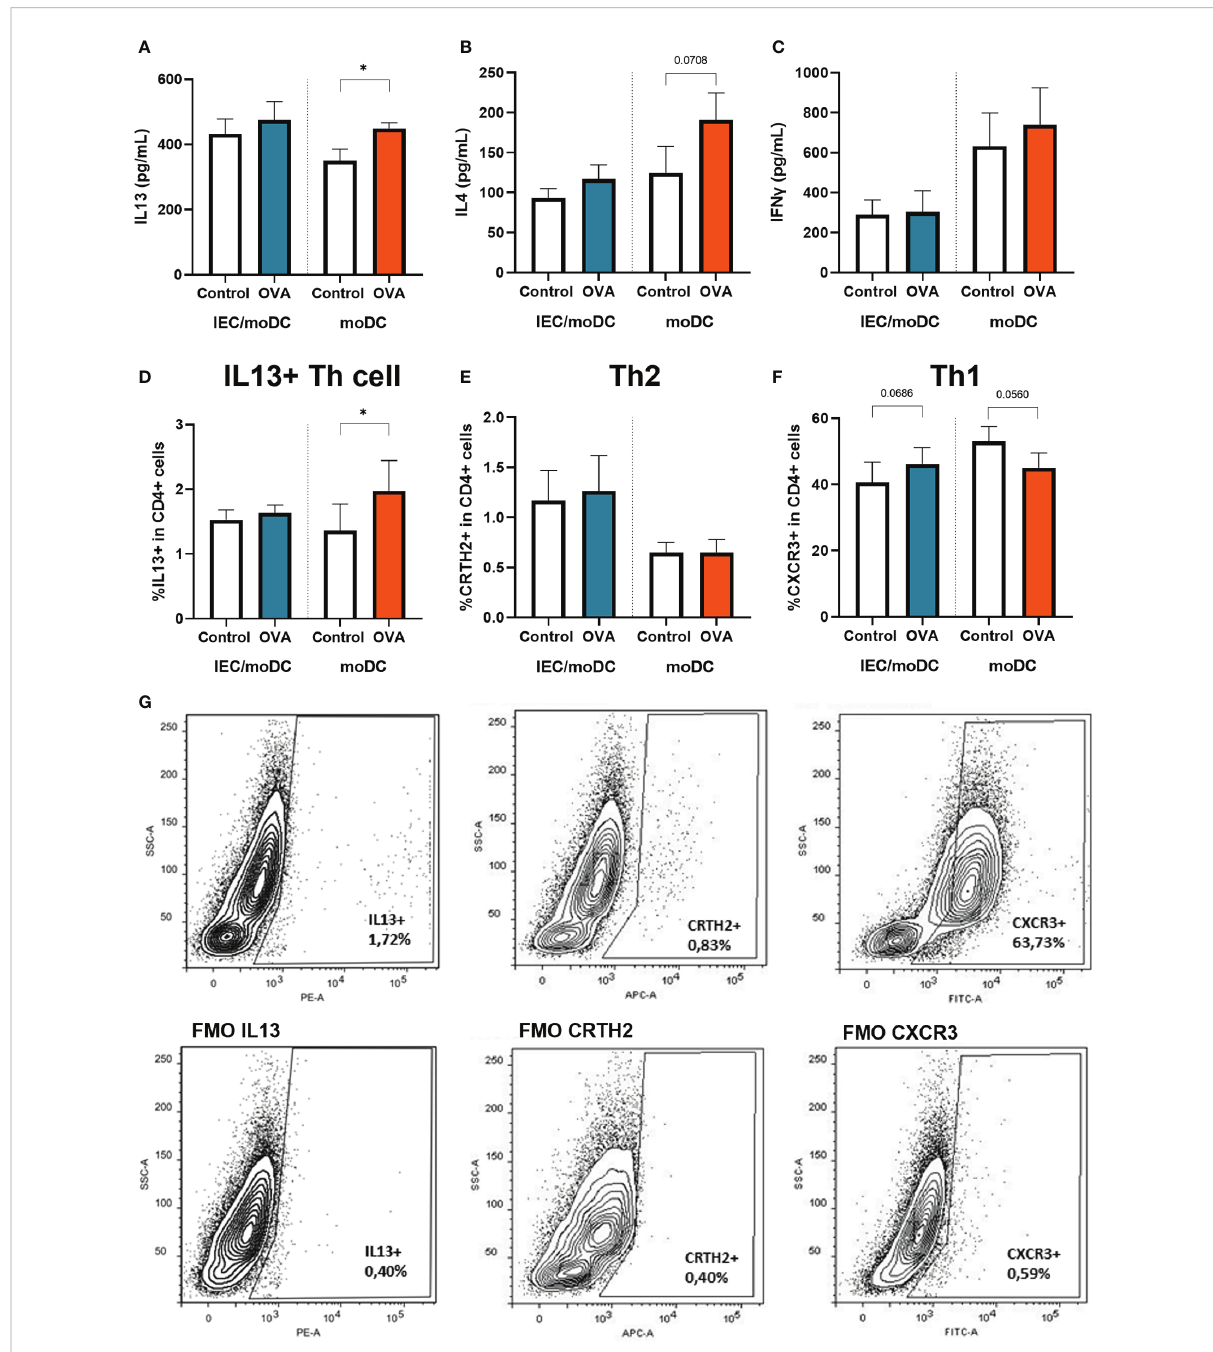
FIGURE 4 OVA-IEC-moDC or OVA-moDC were coculture with allogenic naïve T cells for 4 days. After the coculture period, secreted (A) IL13, (B) IL4, (C) IFN g were measured in the basolateral supernatant. Furthermore, cells were analyzed by fl ow cytometry to determine the percentage of CD4+ cells expressing (D) IL13, (E) CRTH2, and (F) CXCR3. A representative sample and corresponding FMO controls are displayed in G ). Data is analyzed by paired t-test, n=3, mean ± SEM (*